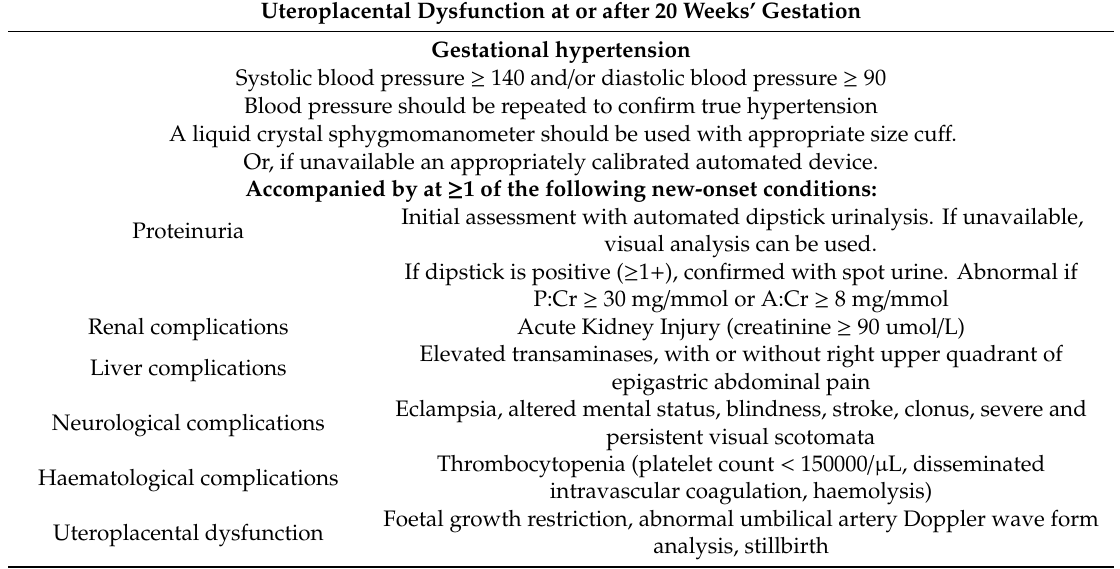
Table 1. Diagnostic criteria for